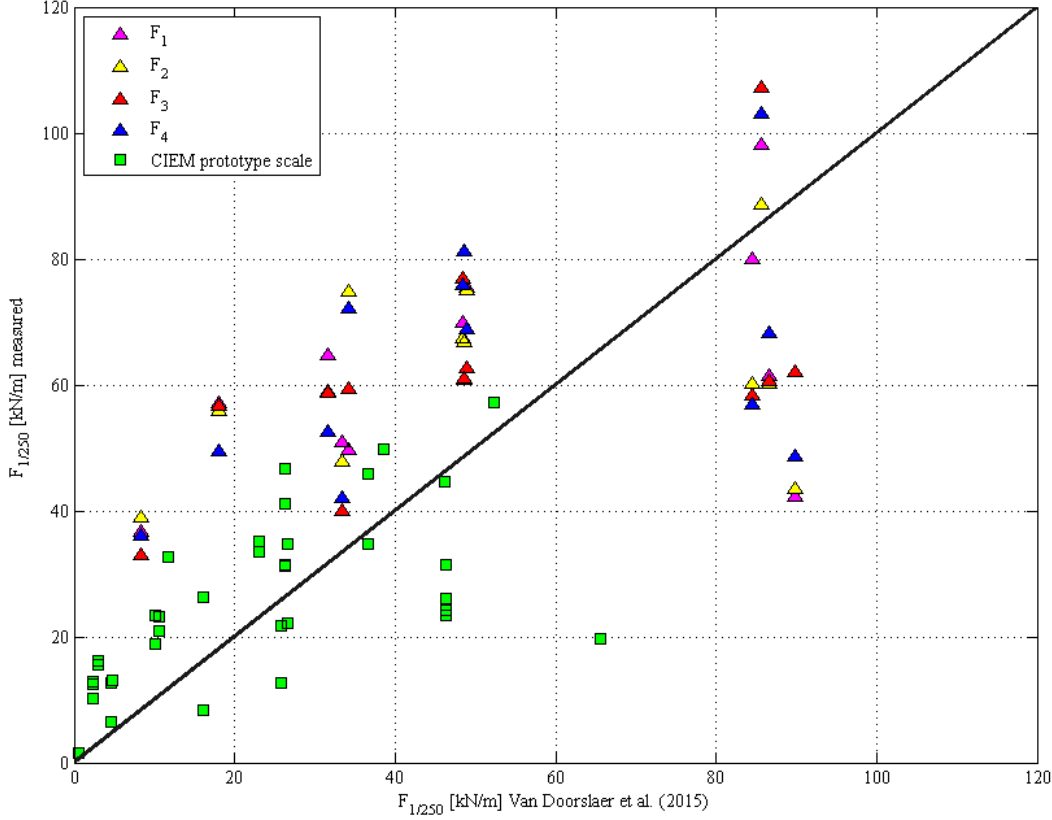
Figure 20. Measured forces versus Van Doorslaer et al. [10] predictions for FHR 0° cases and UPC cases.